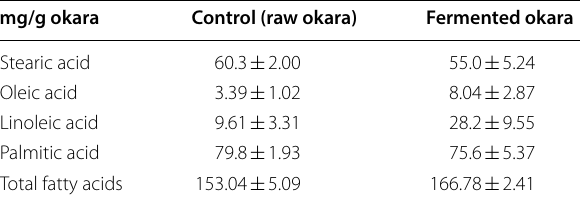
Table 2 Changes in fatty acids in absolute value (mg/g dried okara) for fermented and unfermented okara